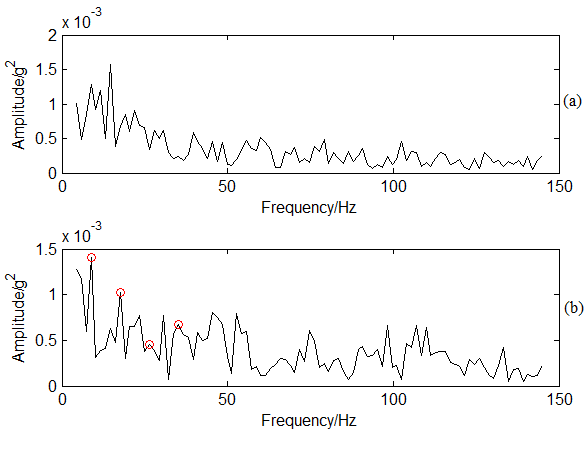
Figure 17. SES for vibration signal under different working conditions: ( a ) Normal conditions; ( b ) Crack